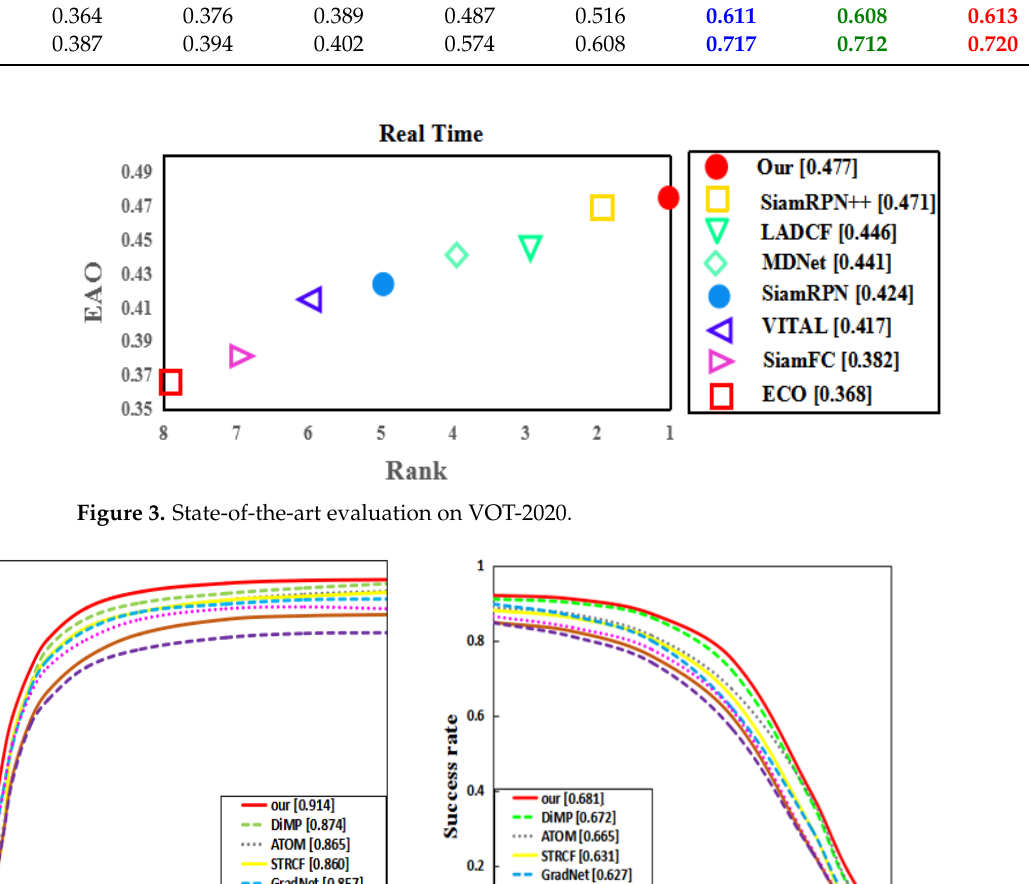
Table 4. Comparison with state-of-the-art trackers on GOT-10k ( Red , Blue , and Green represent the